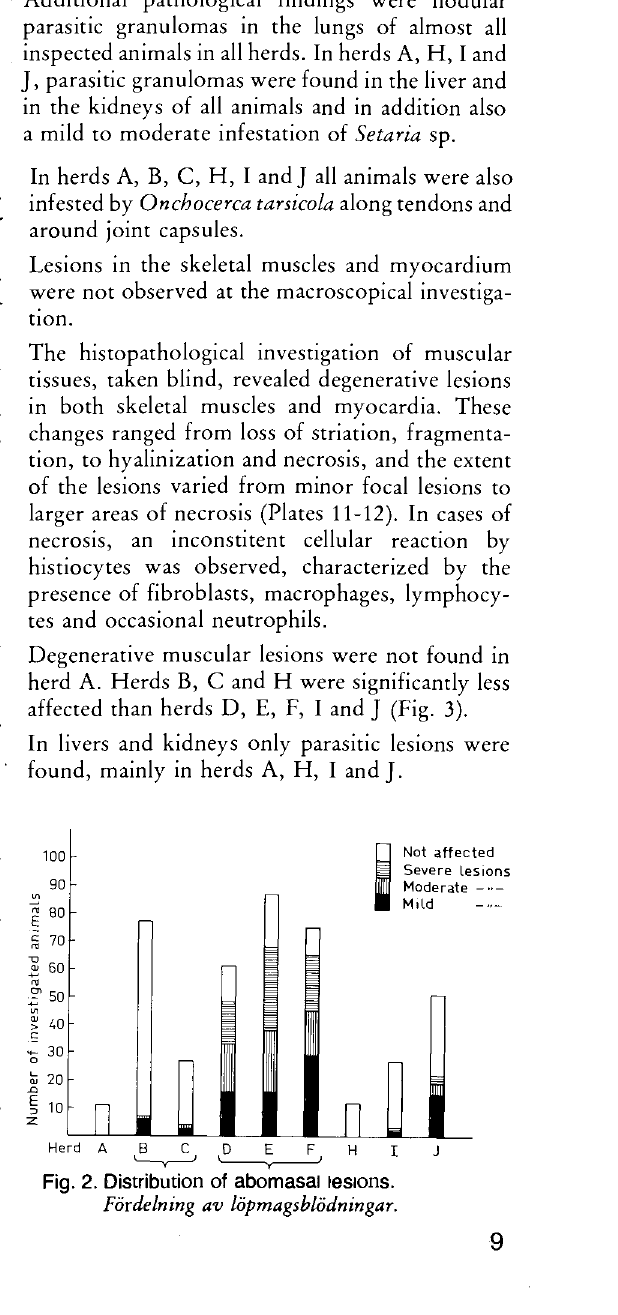
Fig. 2. Distribution of abomasai lesions. Fördelning av